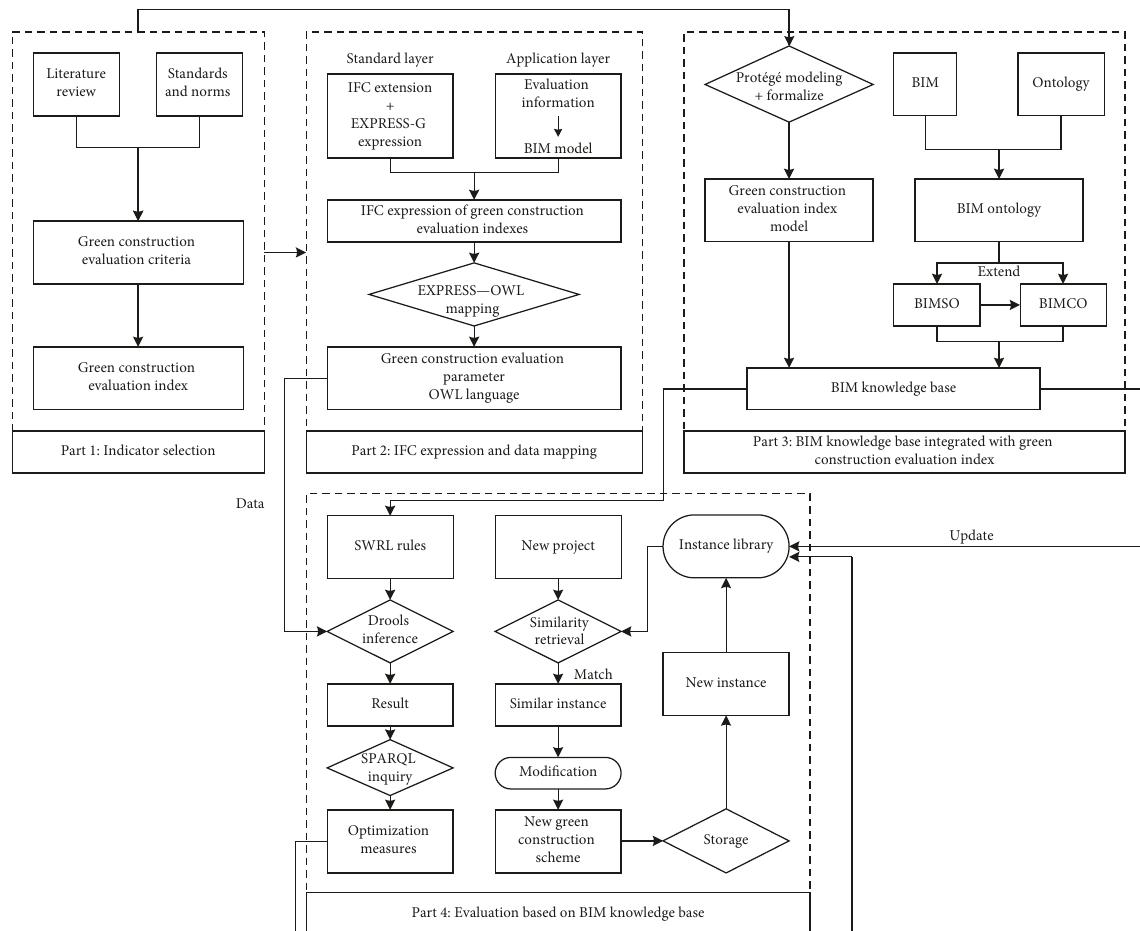
Figure 1: Overview of the implementation of proposed